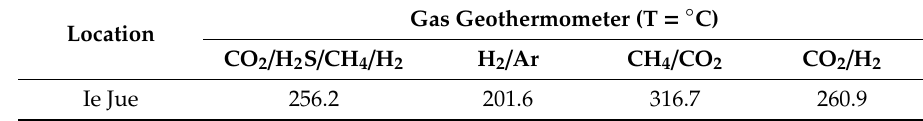
Table 9. Estimation of depth temperature using gas